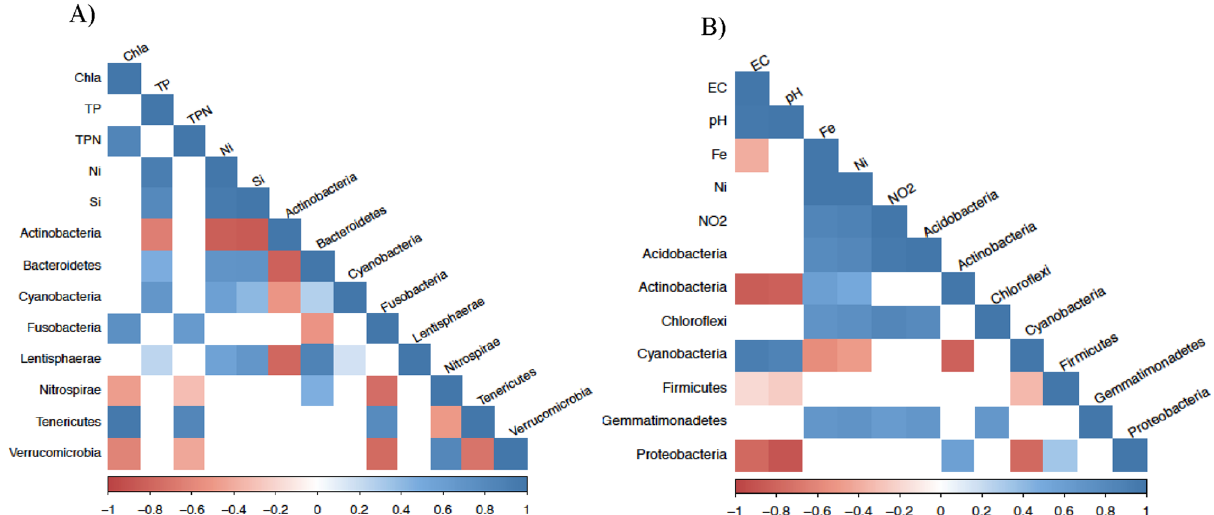
Figure 3. The correlation plot between abiotic parameters with differential abundant groups. The blue squares represent positive correlations, and the red squares represent the negative correlations. The white squares represent the absence of significant correlation ( p < 0.05). The letter ( A ) corresponds to the dry period, while the letter ( B ) corresponds to the wet